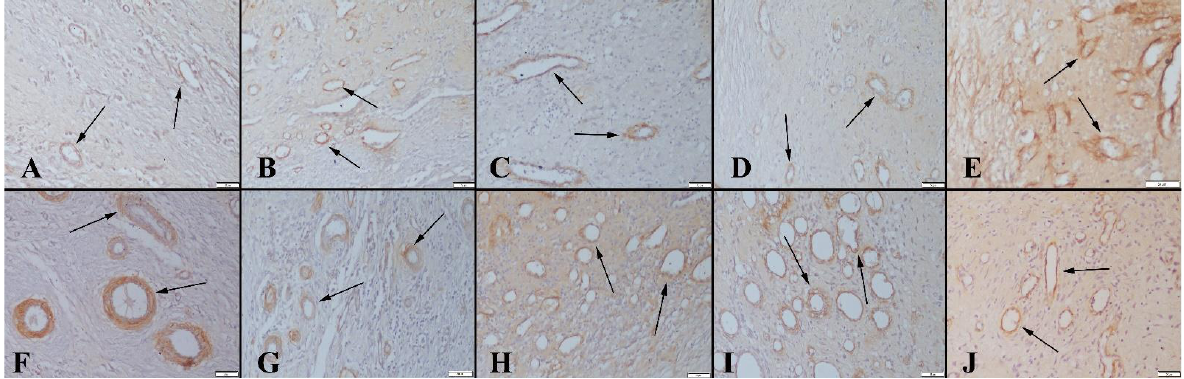
Figure 10. Smooth muscle actin expression among the groups. ( A ) Control group, ( B ) Group 1, ( C ) Group 2, ( D ) Group 3 and ( E ) Group 4, for 4-week and ( F ) Control group, ( G ) Group 1, ( H ) Group 2, ( I ) Group 3 and ( J ) Group 4, for 8-week, arrows indicate immunopositive cells, Strepta- vidin biotin peroxidase method, scale bars = 50 µ